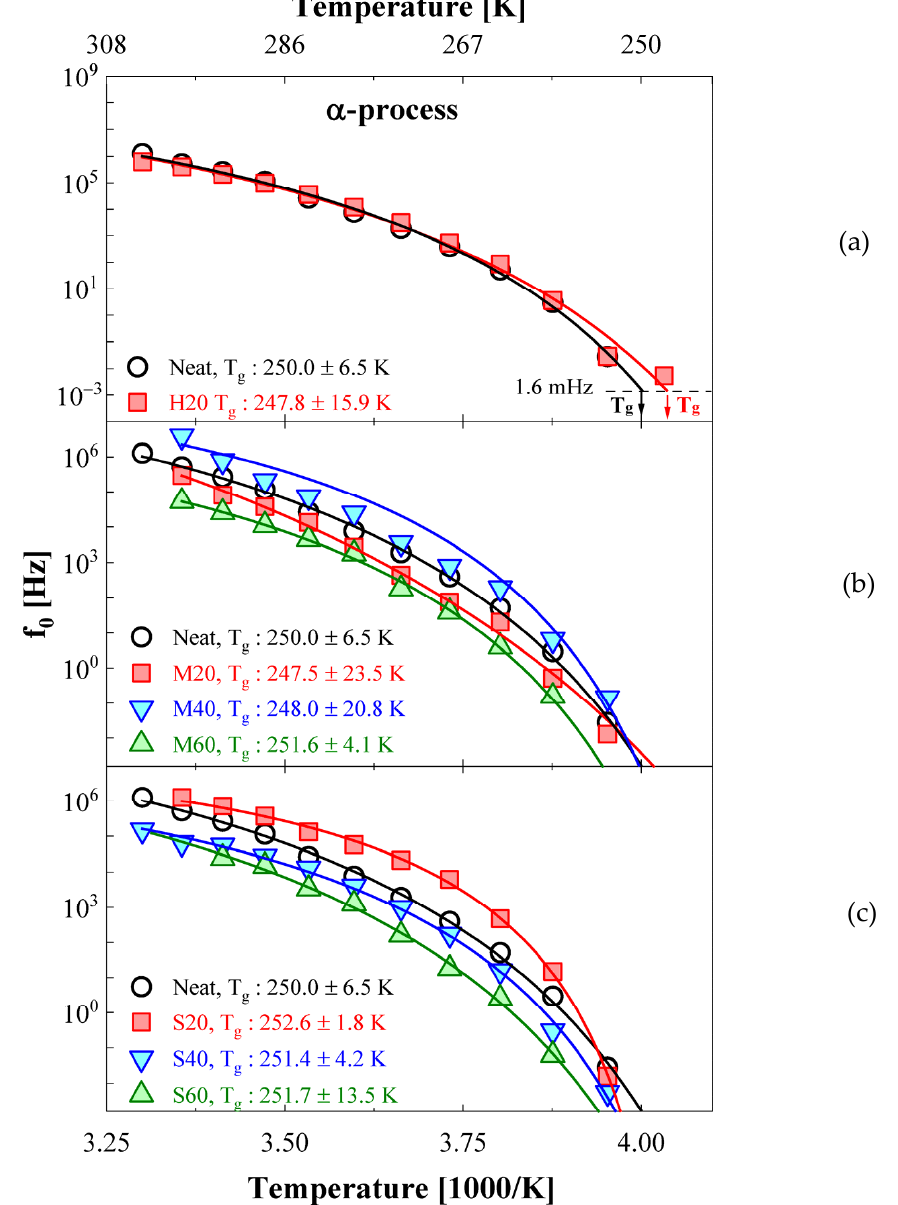
Figure 8. Temperature dependence of the central frequency for the α process on different fillers and contents. ( a – c ) Each H, M, S series. In ( b , c ), f0 is multiplied by arbitrary values so that it can be better distinguished by upshifting or downshifting on the frequency axis. For comparison, three identical neat NBR results are shown on the top, middle, and bottom sides of each figure.